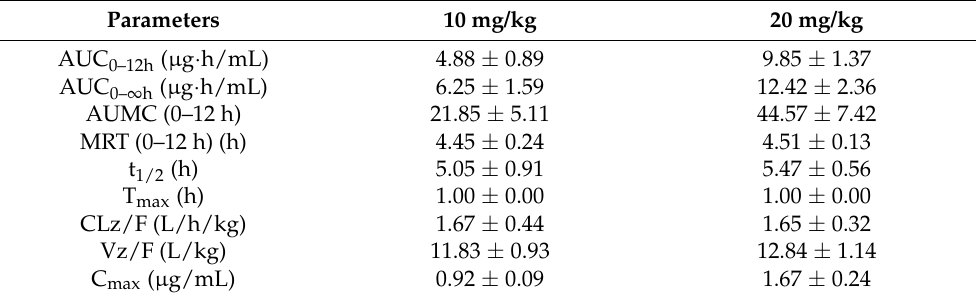
Figure 4. Mean plasma concentration–time plot of sulforaphane (SFN) after a single oral administra- tion of SFN at 10 or 20 mg/kg to rats. All values are mean ± SD ( n = 4 rats). Table 5. Pharmacokinetic parameters of SFN after oral administration at doses of 10 or 20 mg/kg to rats (mean ± S.D., n = 4 rats).